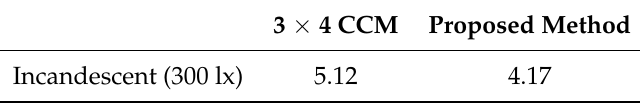
Figure 11. Experimental results under an incandescent lamp (300 lx). ( a ) Optical filtered visible band image; ( b ) 3 × 4 color correction method; ( c ) proposed method. Table 1. Average angular error ( × 10 − 2 ). CCM, color correction